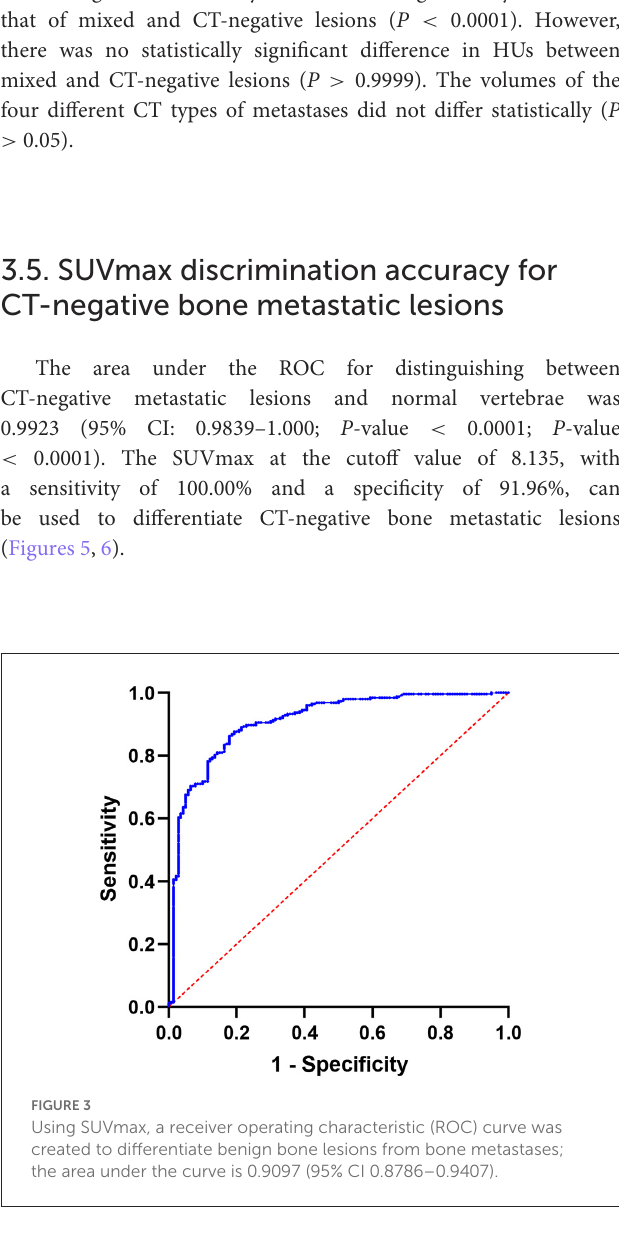
TABLE 3 The number, SUVmax values, HUs, and volume of bone metastatic lesions that were osteoblastic, osteolytic, mixed, or